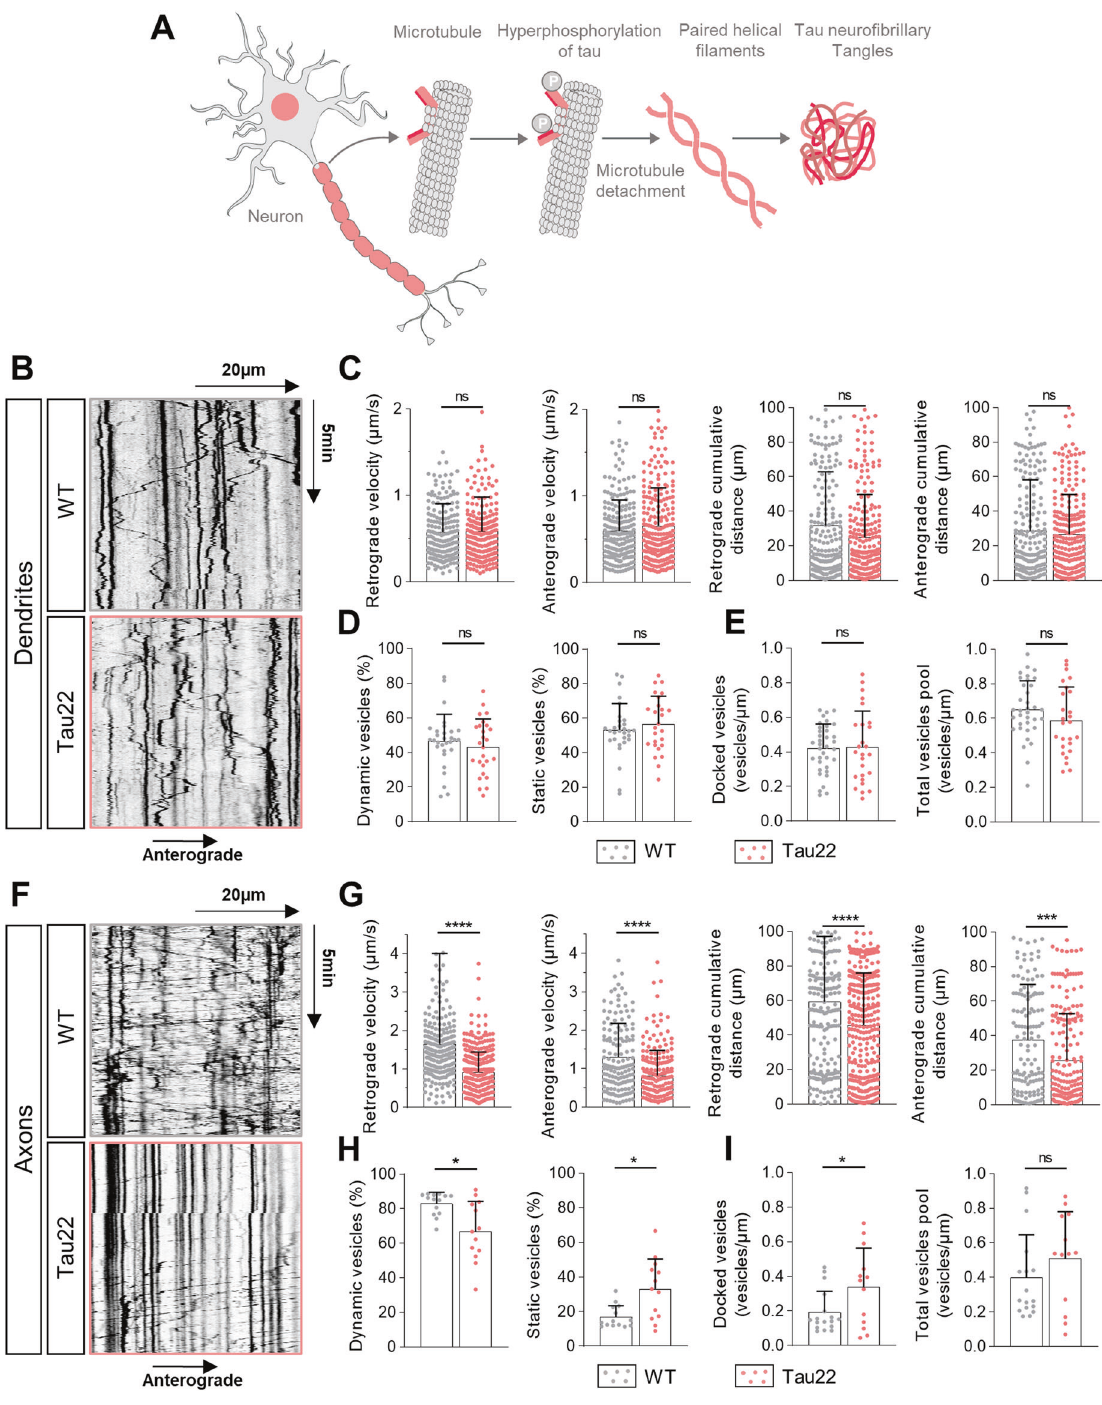
Fig. 7 The traf fi cking of the axonal tPA-containing vesicles is altered in cultured neurons prepared from the Tau22 mouse model of tauopathy. A Diagram showing the formation of neuro fi brillary tangles (NFTs) by the hyperphosphorylation of tau protein in the mouse model Tau22 of tauopathy (inspired from Abcam). B Representative kymographs of dendritic tPA-containing vesicles in WT neurons and Tau22 neurons. C Kymographs analysis of anterograde and retrograde velocity in µm.s − 1 and their respective cumulative distance in µm for each condition. WT n = 196; Tau22 n = 241 vesicles for retrograde traf fi cking and WT n = 210; Tau22 n = 241 vesicles for anterograde traf fi cking. D Percentage of dynamic or static vesicles for each dendrite. WT n = 18; Tau22 n = 19. E Number of docked vesicles and the total vesicles pool for each dendrite per µm. WT n = 18; Tau22 n = 19 ( C – E ) from 15 to 16 neurons from 3 to 4 independent cultures. F Representative kymographs of axonal tPA- containing vesicles in WT neurons and Tau22 neurons. G Kymographs analysis of anterograde and retrograde velocity in µm.s − 1 and their respective cumulative distances in µm for each condition. WT n = 252; Tau22 n = 377 vesicles for retrograde traf fi cking and WT n = 144; Tau22 n = 201 vesicles for anterograde traf fi cking from 13 to 14 neurons from 3 to 4 independent cultures. H Percentage of dynamic or static vesicles for each axon. WT n = 13; Tau22 n = 14. I Number of docked vesicles and the total vesicles pool for each axon per µm. WT n = 13; Tau22 n = 14 ( H , I ) from 13 to 14 neurons from 3 to 4 independent cultures. C , D , E , G , H Samples were drawn from at least three independent experiments. Statistical tests: two-tailed Mann – Whitney test, *p < 0.05; ***p < 0.005; ****p < 0.0001, ns not signi fi cant. Kymograph scales: x = 40 µm, y = 10 min. Cell Death and Disease (2023)